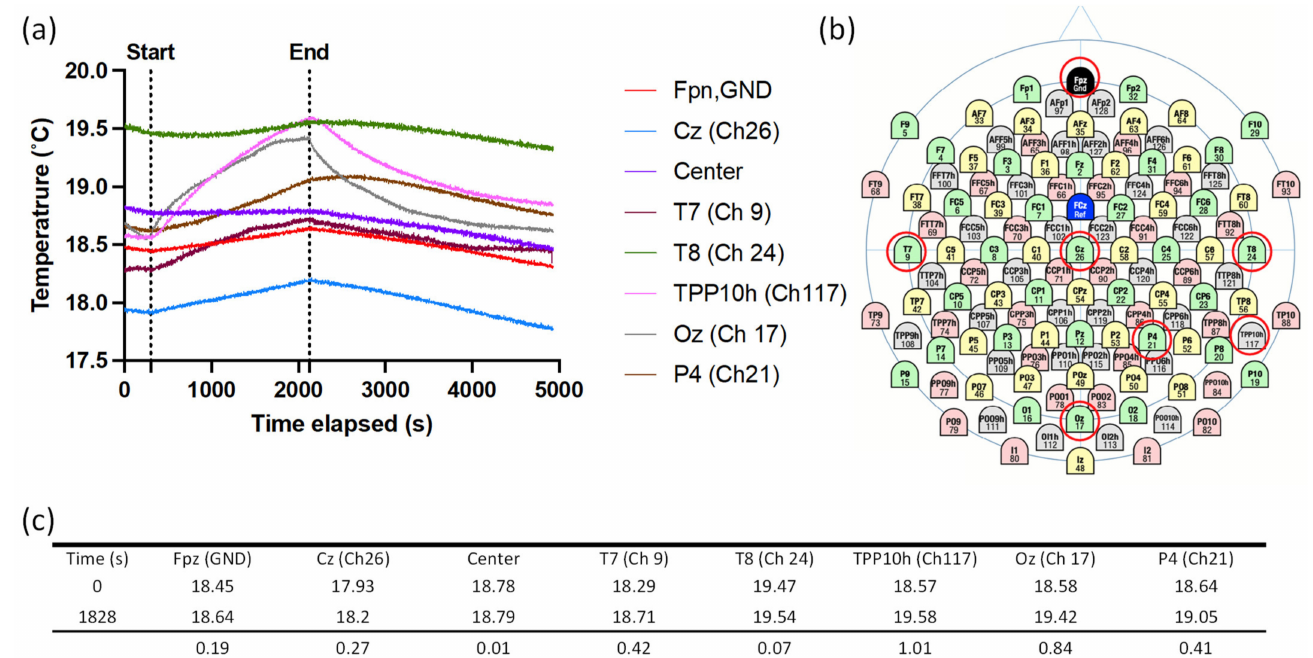
Figure 5. 3 T MRI RF safety test results of the NeoNet with a child head phantom. ( a ) Temperature elevation with a high-power turbo spin-echo sequence with a maximum allowed input power in a clinical scan for 30 min using a birdcage body transmit coil. ( b ) Distribution of 128-channel EEG traces and the position of EEG electrodes where the temperature was monitored. ( c ) Table of relative temperature changes in the location of the electrodes monitored (red circle) over 30 min of